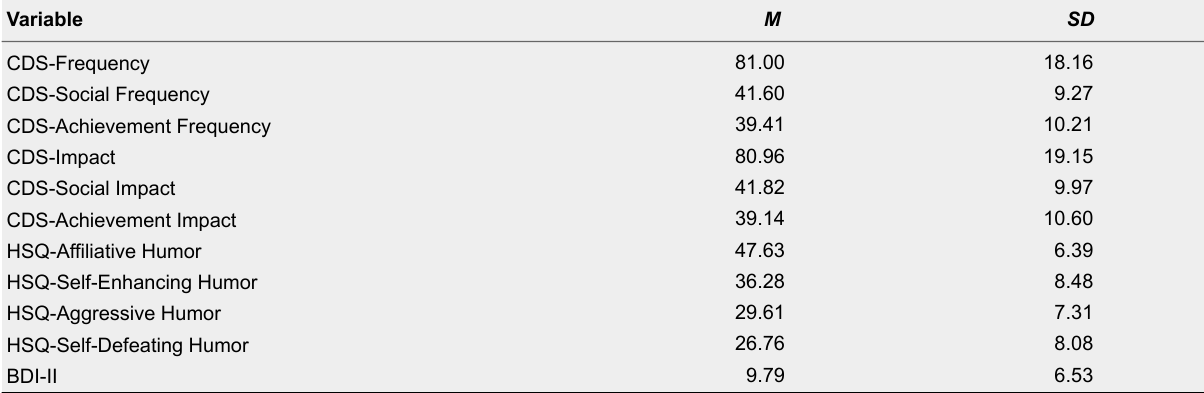
Descriptive Statistics for Cognitive Distortions, Humor Styles, and Depressive